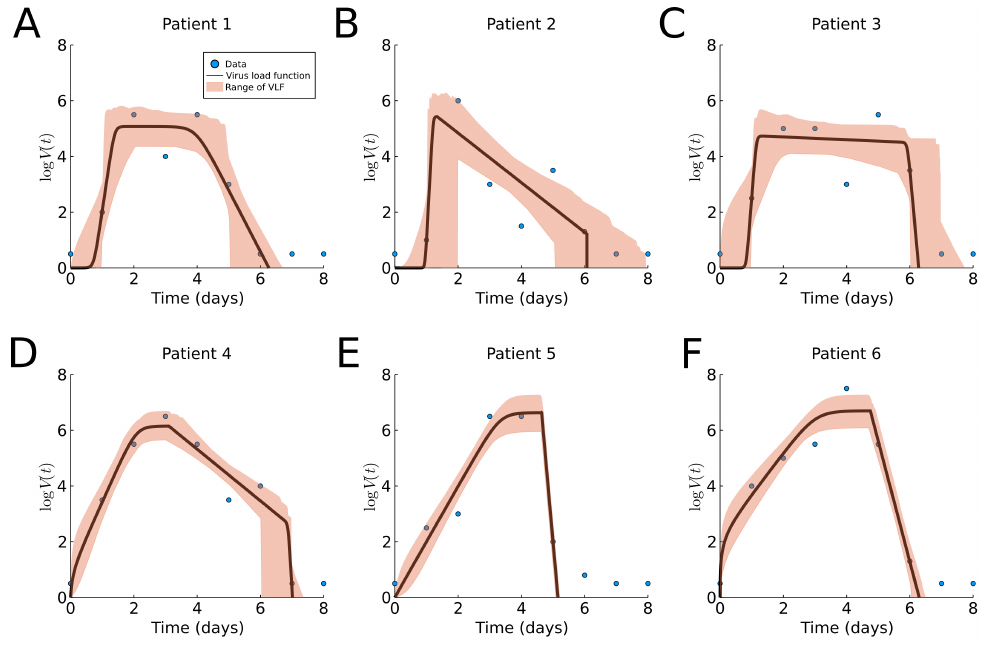
Figure 6. Fitting results of the virus load function (1) to human Influenza A data data [7]. The blue dots represent the individual measurements, and the black line is our best fit. The area in red represents the likelihood range of virus load functions. ( A – F ) Patients 1 to 6,